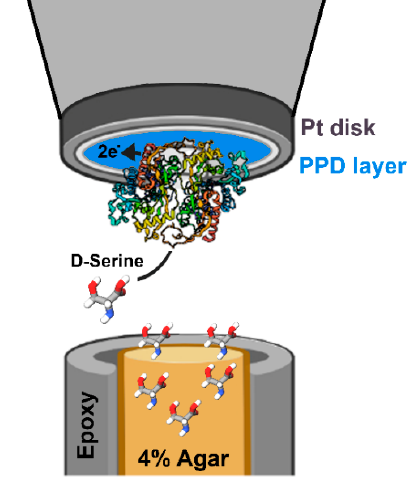
Figure 4. Set up of a scanning electrochemical microscopy (SECM) system for imaging surface topography and local reactivity by scanning a small-scale probe (in the micrometer range) over an immersed substrate immersed in 4% agar and embedded in an epoxy puck, while recording the current. The system is based on a disk-shaped amperometric RgDAAO biosensor deposited on a 25 µ m diameter platinum disk microelectrode with an electrodeposited PPD layer. Modified from [84].